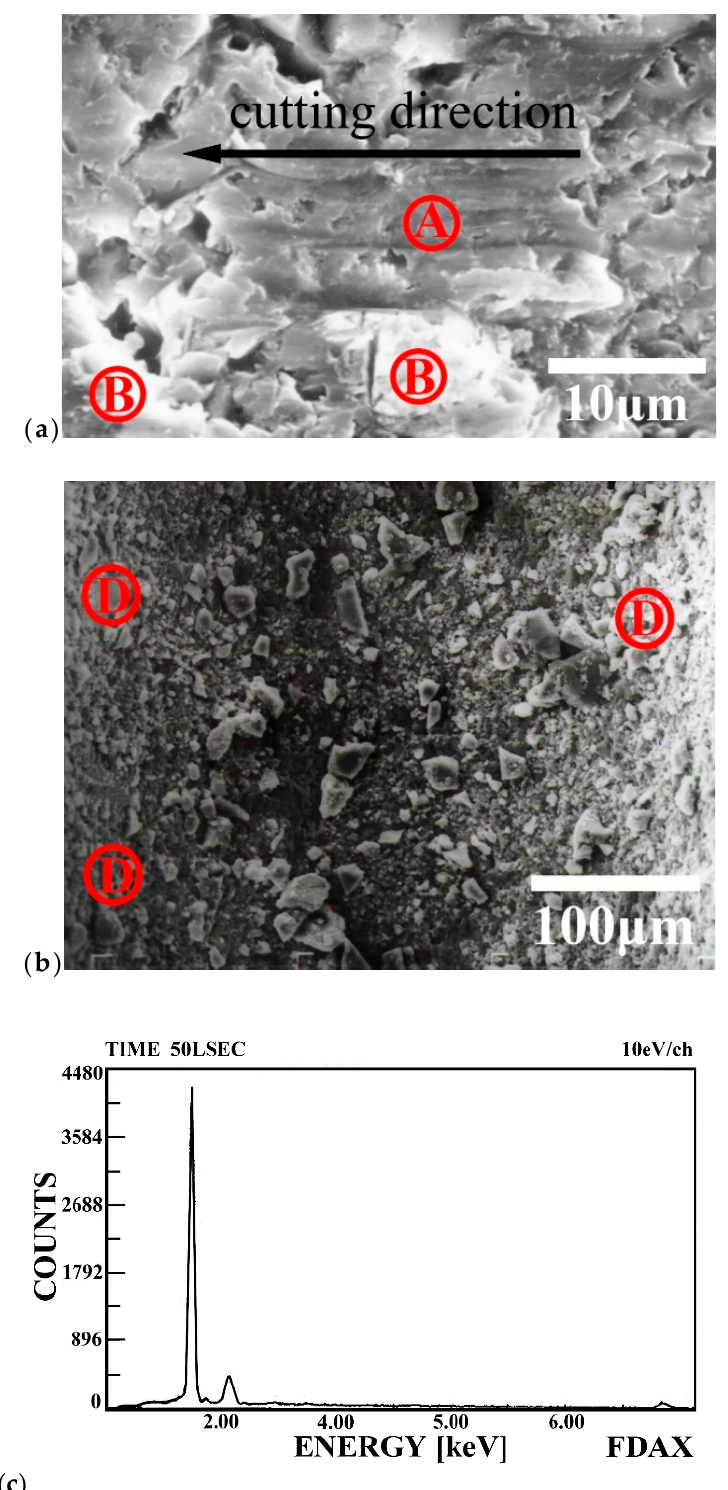
Figure 2. Wire-saw machining of Al 2 O 3 using SiC (working load of 1.27 N, wire speed of 2.8 m / s): ( a ) plastic deformation at position A and brittle fracture at position B; ( b ) debris at position D; ( c ) energy-dispersive spectrometry results for the debris shown in Figure 2b.